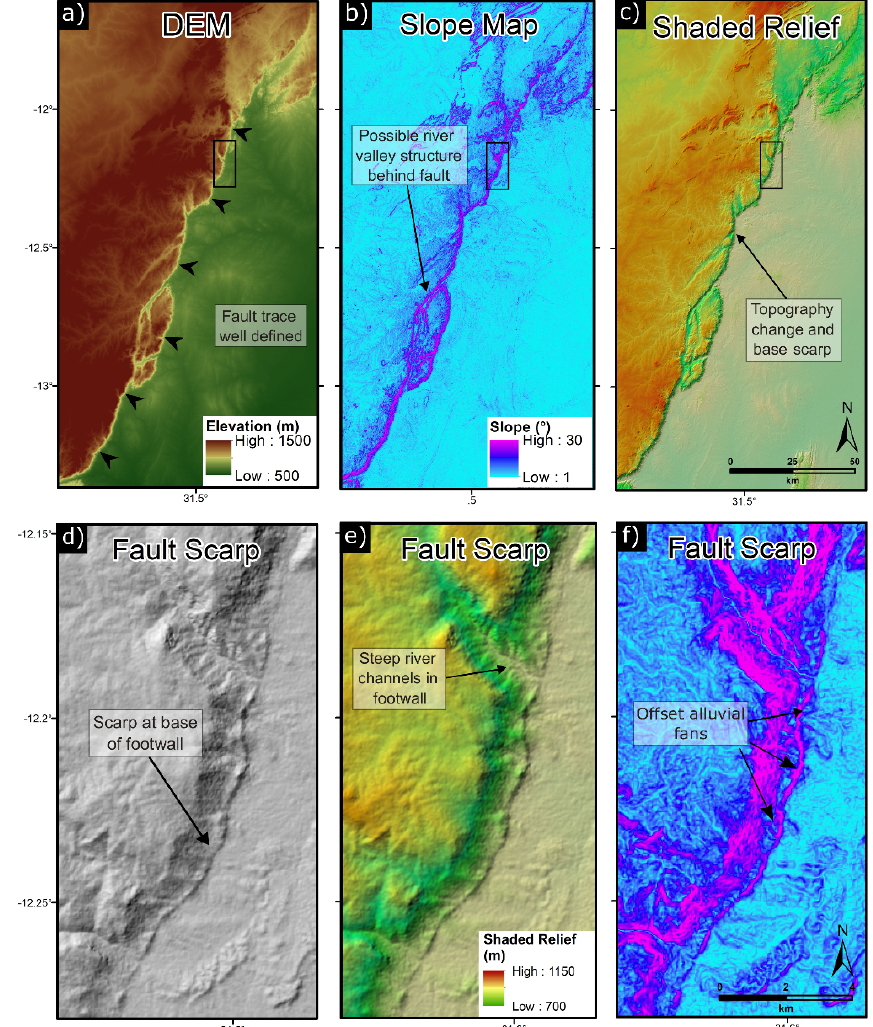
Figure 5. The Chipola Fault. (a–c) Overview of the Chipola Fault shown in the DEM; slope and shaded relief maps adapted from SRTM data (Farr et al., 2007). The fault is notable for the steep (25–30 ◦ ) fault scarp at the base of the ∼ 1000m high escarpment. (d–f) Hillshade, shaded relief, and slope maps showing a zoomed-in section of the Chipola Fault indicating the Quaternary fault scarp that has formed at the base of the escarpment and that has offset alluvial fan